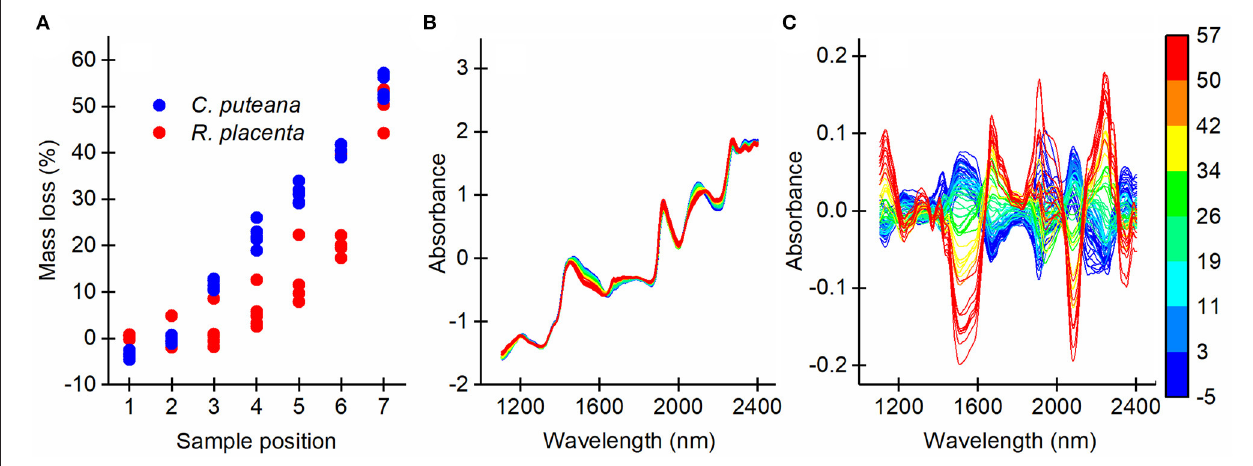
FIGURE 2 | Mass losses of all sample blocks caused by C. puteana and R. placenta (A) and the SNV transformed average NIR spectra of the samples before (B) and after mean-centering (C) colored according to mass loss.